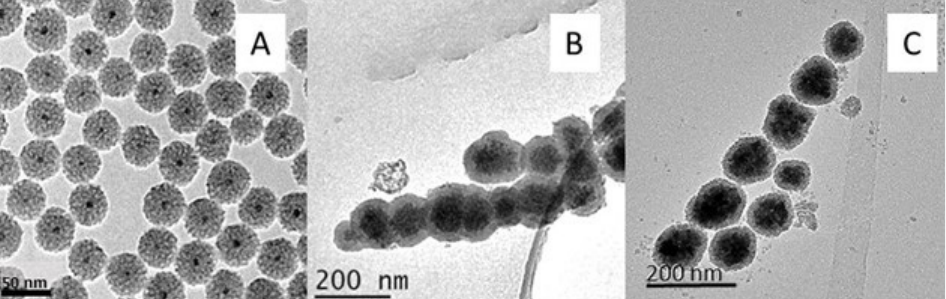
Figure 3. Transmission micrographs of Fe 3 O 4 @SiO 2 nanoparticles (Method B); ( A ) magnetic nanoparticles 10 nm (Method 3); ( B ) magnetic nanoparticles via solvothermal (Method 1); and ( C ) magnetic nanoparticles via solvothermal (Method 2) with 18-fold increase in reagents and solvents.